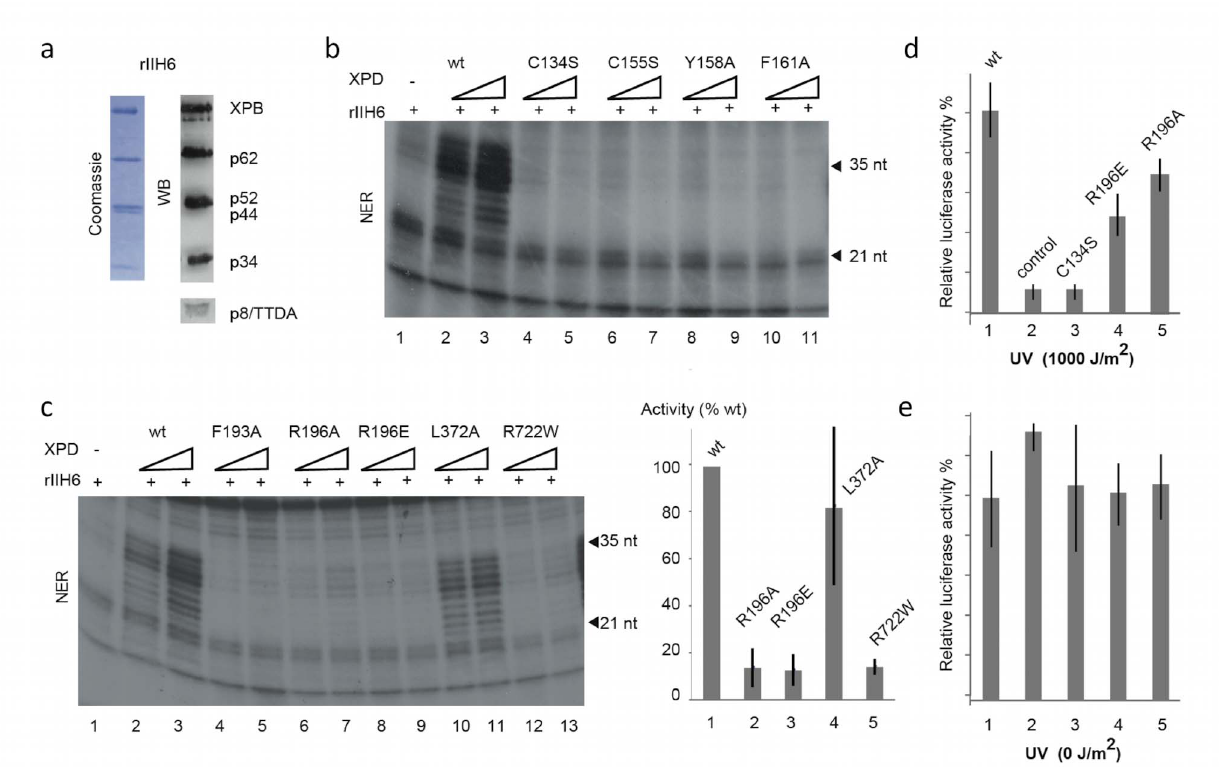
Figure 4. NER activity of hsXPD and its variants. (a) Purified core-TFIIH (rIIH6) resolved by SDS-PAGE followed by Coomassie staining and Western blot analysis. (b and c) NER activity of reconstituted TFIIH containing mutant XPD proteins. XPD wild type or variants (100 and 200 ng) were mixed with purified core-TFIIH (rIIH6) and added to an in vitro double-incision assay using recombinant NER factors. The reaction was analyzed by electrophoresis followed by autoradiography. Incision activities from three independent experiments were quantified and normalized to wild type. (d and e) Host cell reactivation activity of XPD variants. HD2 fibroblasts were transfected with a reporter plasmid expressing firefly luciferase previously exposed to 1,000 J/cm 2 UVC-light (254 nm) (d) or with the nonirradiated control (e) in combination with vector expressing renilla luciferase to normalize transfection efficiencies and pIERS2-EGFP expressing XPD wild-type or mutant proteins. The firefly luciferase activity in cell lysates (48 h posttransfection), normalized with the internal renilla luciferase standard, assesses repair complementation. The values of three independent experiments are presented as percentages, with 100% being the level of luciferase activity obtained with wild-type XPD. The data used to generate panels (c), (d), and (e) have been deposited as supplementary information in xls format (Table